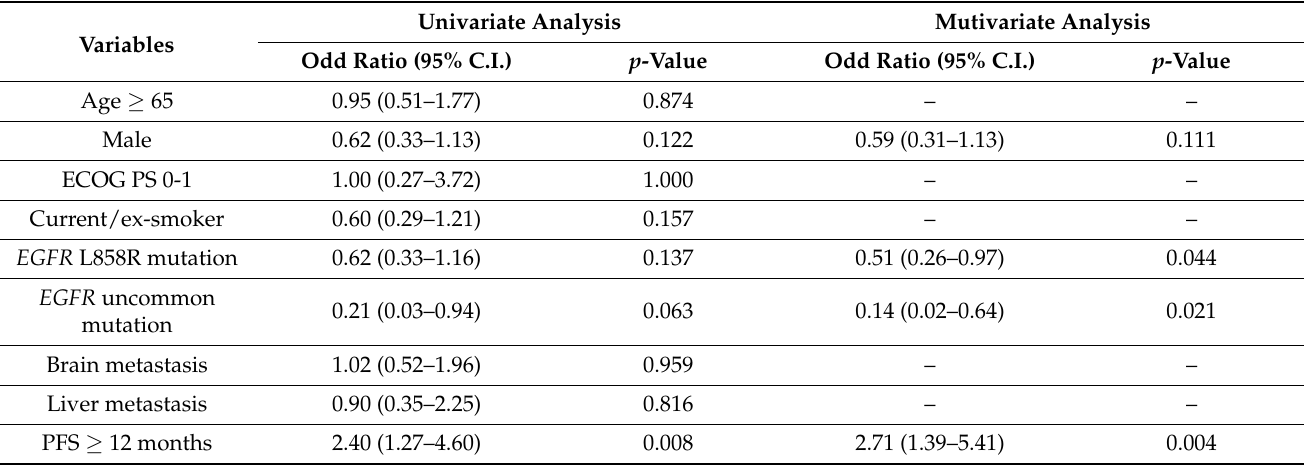
Table 5. Factors associated with T790M